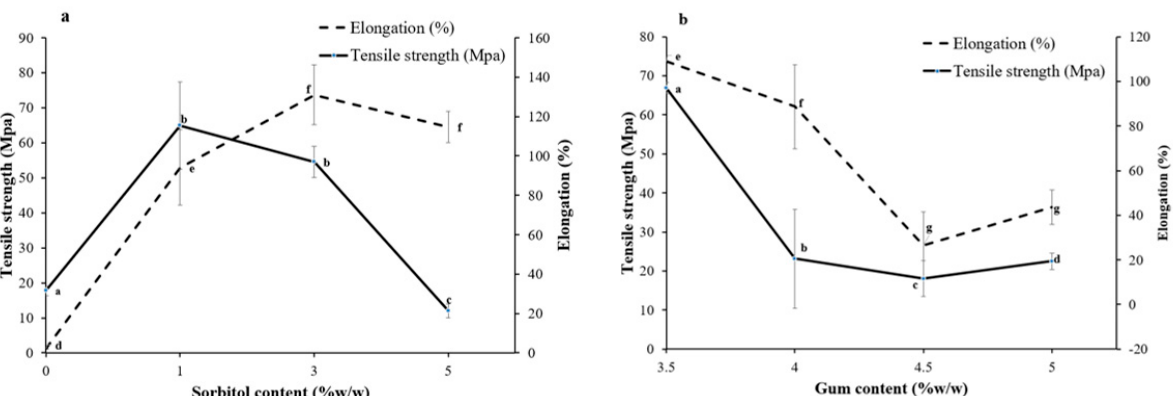
Figure 1. Correlation between mechanical properties (stress (dashed line) and strain (solid line)) and portion of ( a ) sorbitol (gum fixed at 5%) ( b ) gum (sorbitol fixed at 3%) of the printing substrate (a letter on the graph indicates the level of significance; bars denoted by the same letter are not statistically significant ( p > 0.05)).